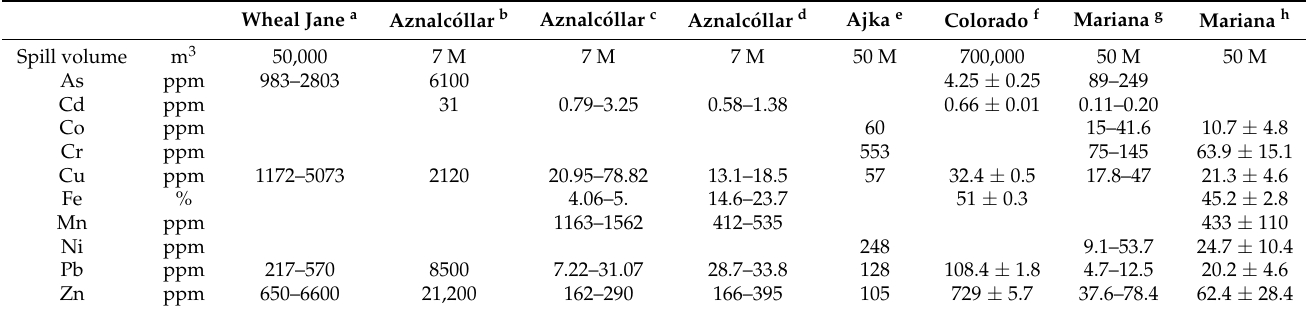
Table 4. Comparison of the elemental composition in sediments from fluvial networks affected by spillages from different mine